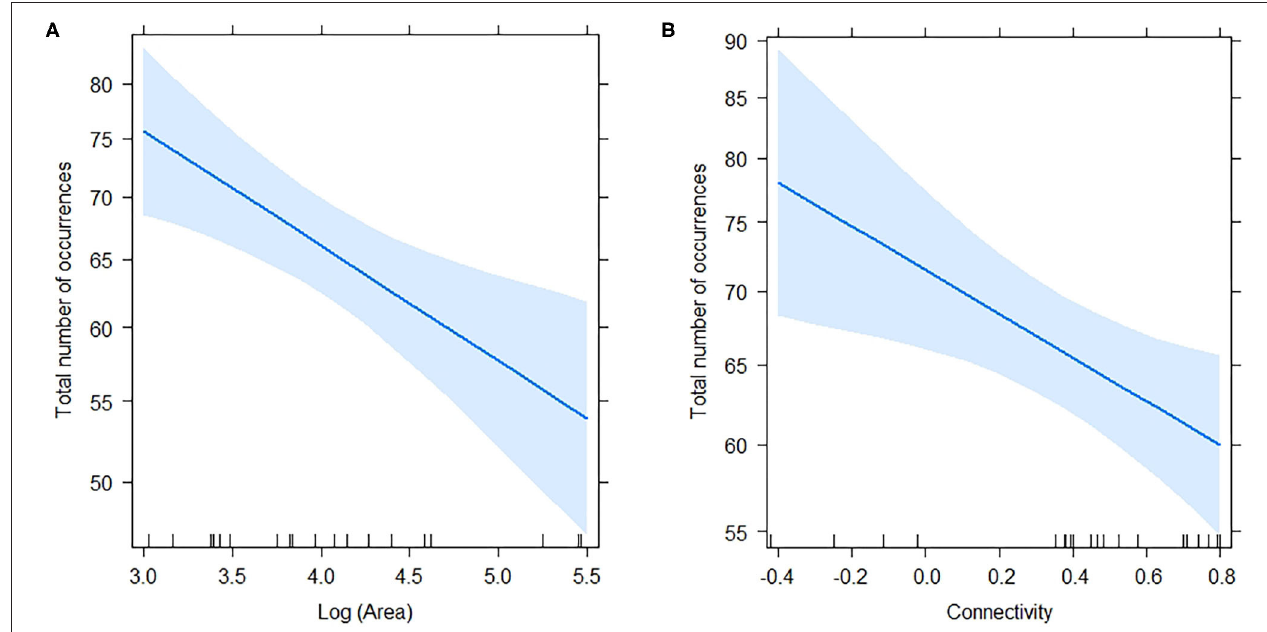
FIGURE 2 | Effects of Log (Area) (A) and Connectivity (B) on Total number of occurrences estimated by the complete model (including the interaction; see Table 5 ). Shaded regions represent 95% confidence intervals. The model was a GLM with Poisson distribution and log link